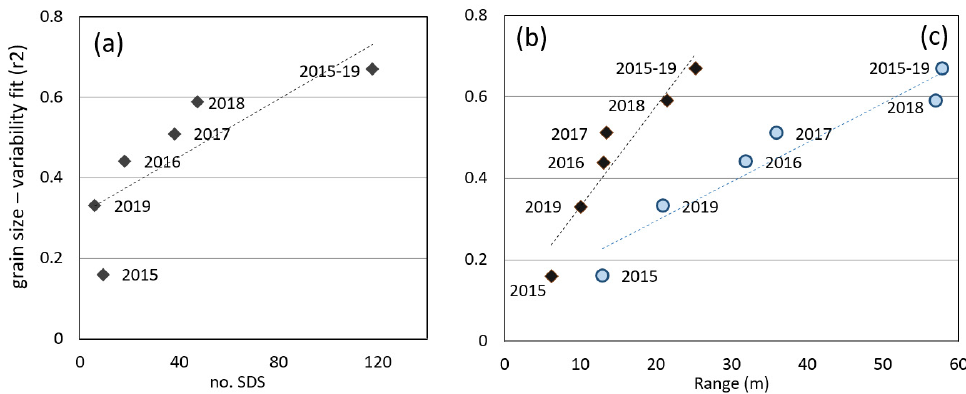
Figure 11. Plots of the annual goodness of the fit grain size–variability as σ (Y-axis) versus (X-axis): ( a ) amount of SDS considered, ( b ) average range of shoreline change, and ( c ) range of the sea level change coinciding with the instant of SDS acquisition. All variability values were defined for 200 m buffers.